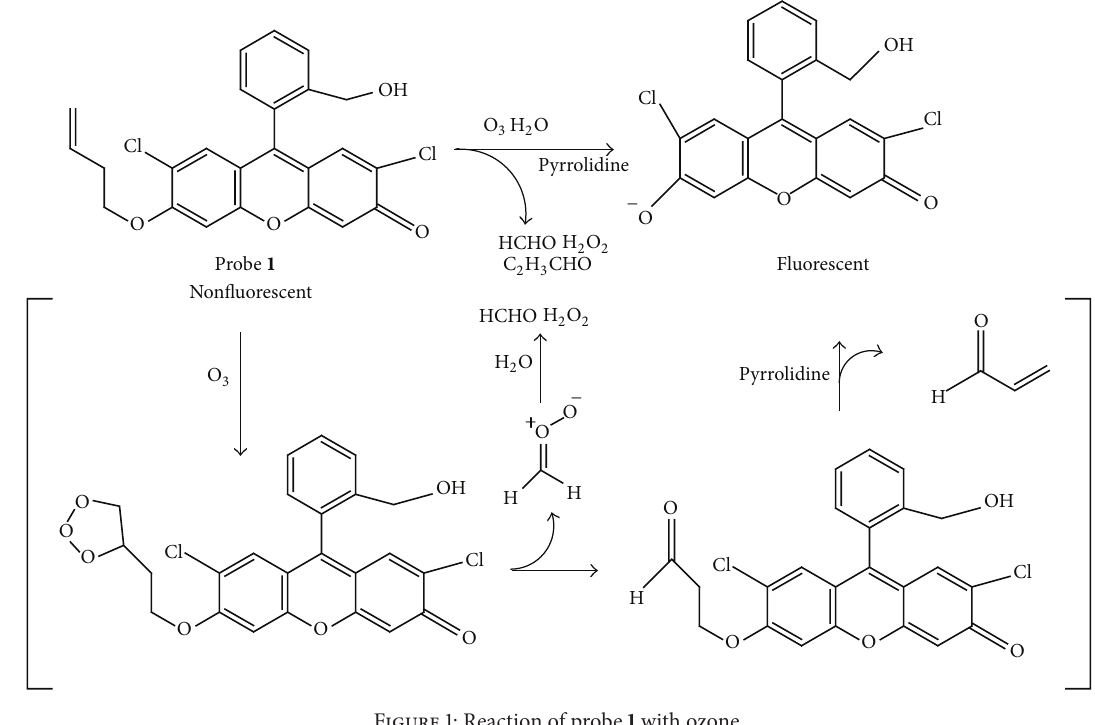
Figure 1: Reaction of probe 1 with ozone.